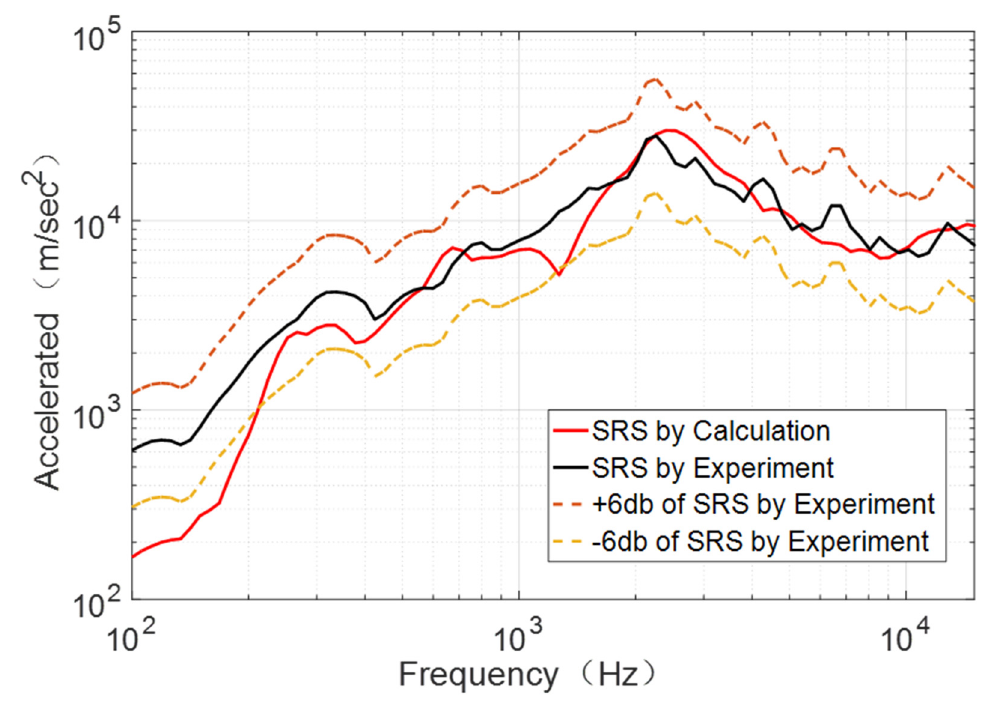
Figure 10. Shock responses of experiment and calculation for plate 1.